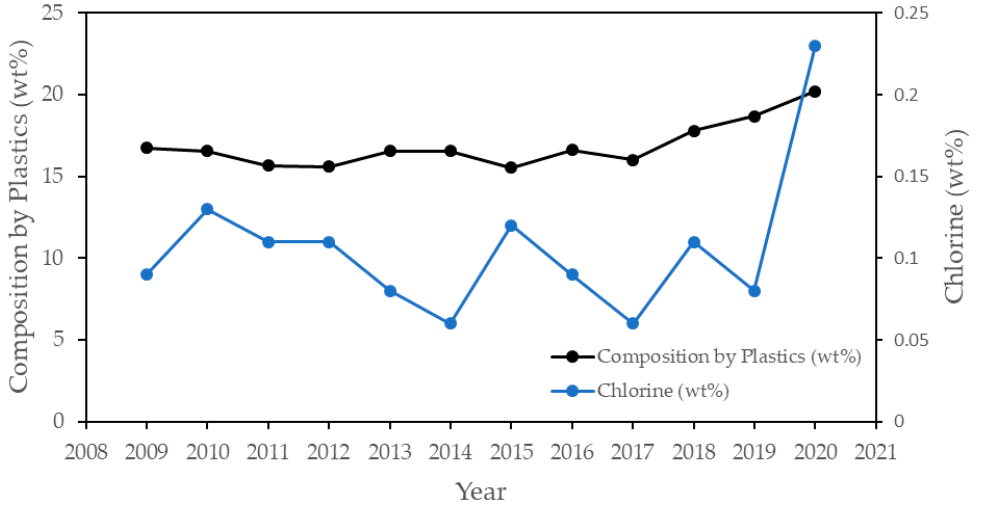
Table 4. Reported amounts of garbage (general waste) generation, proximate analysis and compo- sition by plastics in Taiwan since 2018 1 . Figure 3. Variations in garbage compositions by plastics and elemental chlorine during the period of